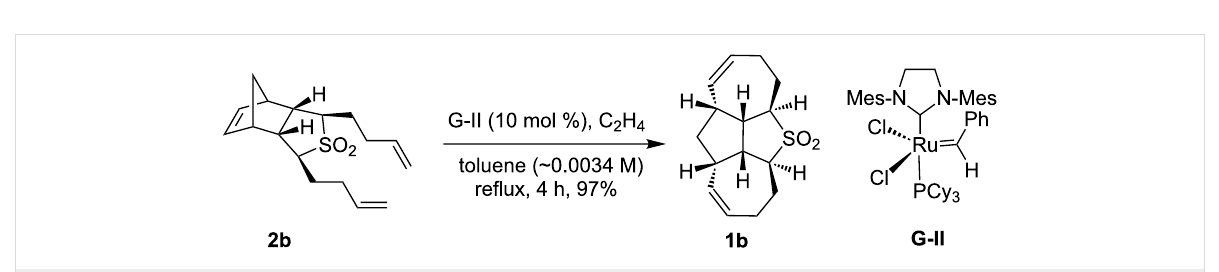
Scheme 4: Synthesis of 1b using